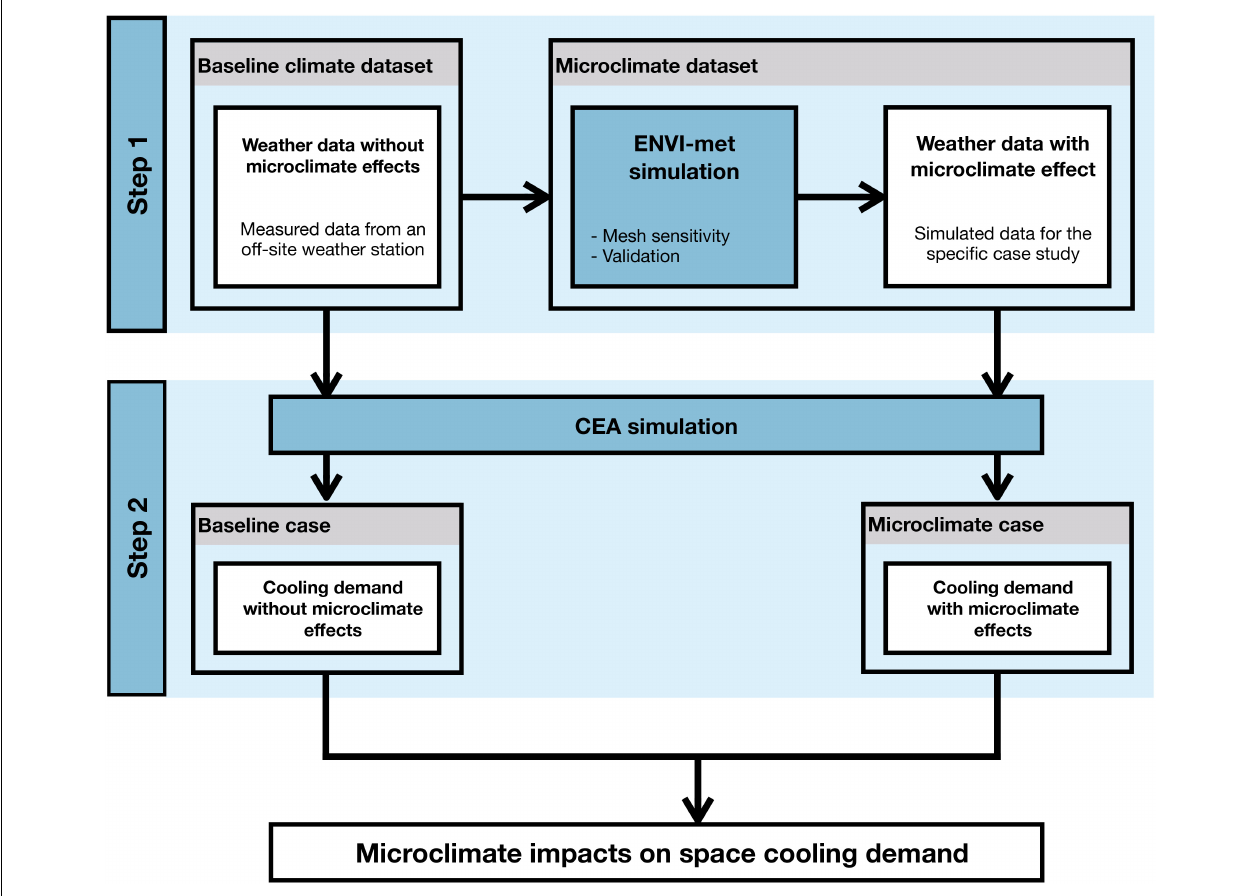
FIGURE 1 | Schematic showing the proposed integration method between ENVI-met and CEA for each of the climatic cases